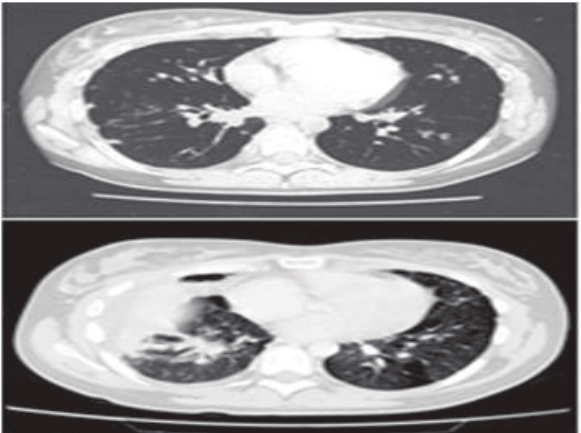
Figure 1: CT scan of the thorax. A: multiple bilateral centimetric and sub-centimetric pulmonary. B: extensive areas of consolidation in the right middle and lower lobes, and bilateral centimetric pulmo- nary nodular opacities.